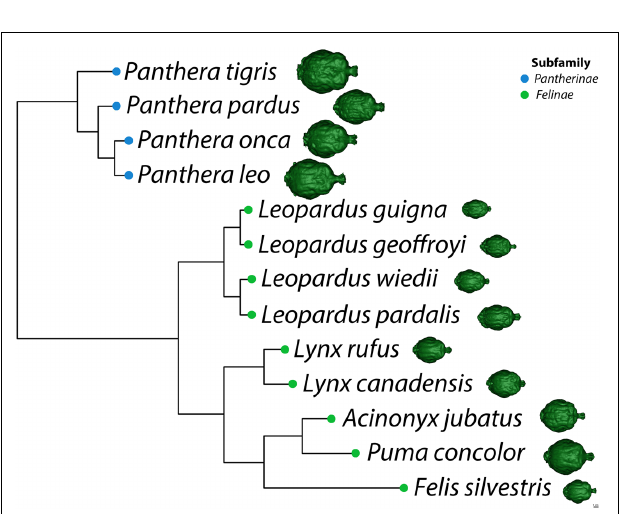
FIGURE 3 | Phylogeny of selected felid species adapted from Johnson et al. (2006). A dorsal view of each species’ virtual endocast is shown to scale on the